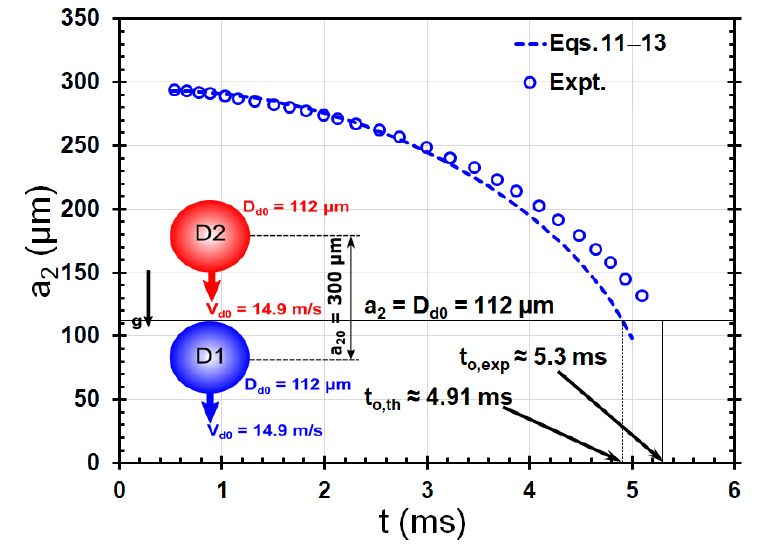
Figure 2. Typical time evolution of the center-to-center separation of an iso-propanol double-droplet system ( ρ d = 786 kg/m 3 ) injected into ambient air ( ρ ∞ = 1.2 kg/m 3 ; µ ∞ = 1.81 × 10 − 5 Pa · s), from ex- periments [27,28] (symbols) and as predicted by Equation (13) (line). Initial conditions (at t = 0.5 ms): D d 0 = 112 µ m; a 20 = 293 µ m; V d 0 = 14.9 m/s; C D is calculated using Equation (10). The initial values of Reynolds number and aerodynamic Weber number are 110.6 and 1.38, respectively. Adapted from